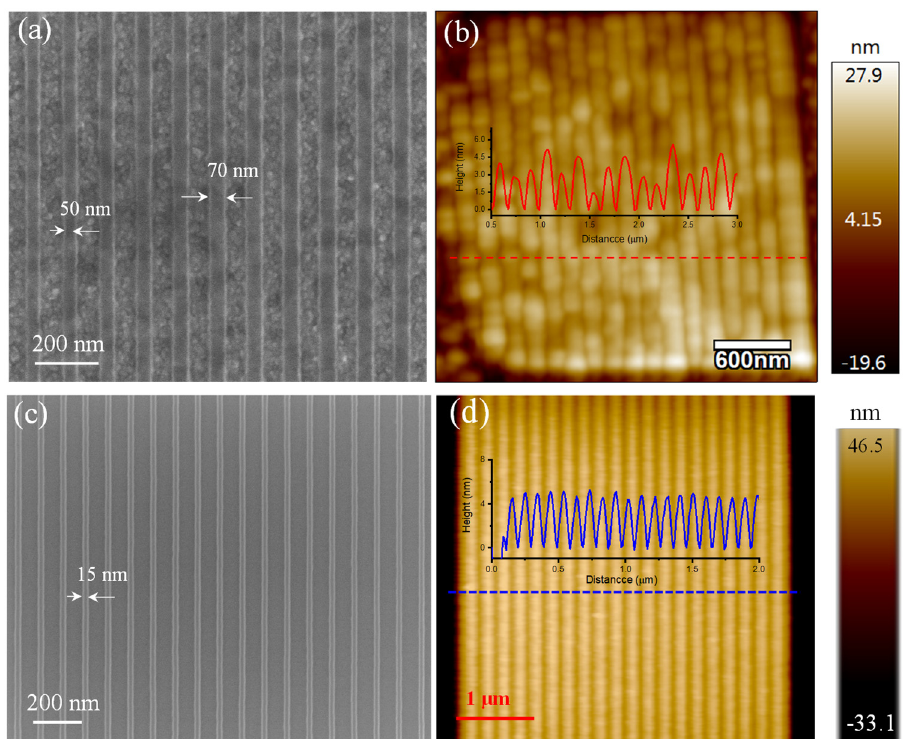
Figure 5. Graphene nanoribbons. ( a , c ) SEM images of graphene nanoribbons fabricated by e-beam direct writing on copper film substrate and SiO 2 /Si substrate, respectively. ( b , d ) AFM images of graphene nanoribbons on copper film substrate and SiO 2 /Si substrate, respectively.